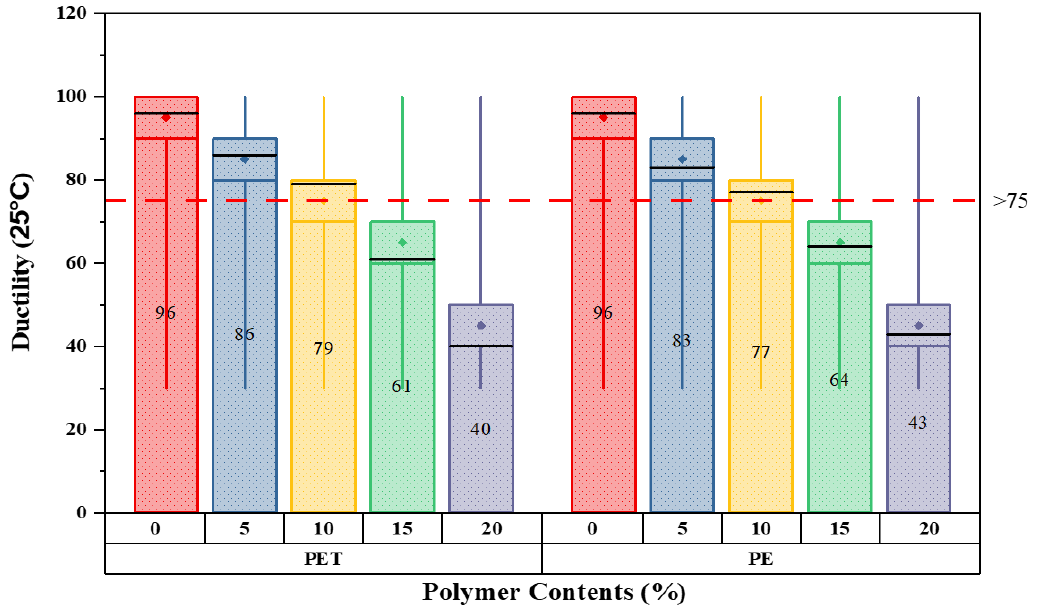
Figure 8. Ductility values with varying plastic content percentages .